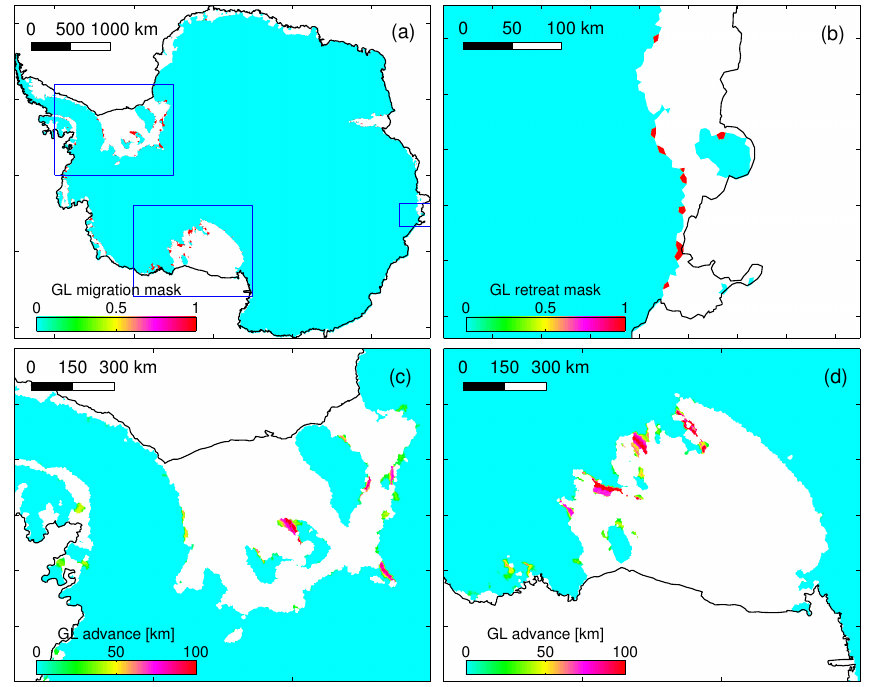
Figure 7. Influence of GIA uplift on the GL. (a) The mask of GL migration associated with the GIA solution at AD 2500. Calculations are based on the hydrostatic equilibrium criterion for the current distribution of ice thickness. Cyan depicts the extent of present-day grounded ice. Red shows the GL migration (mostly advance) due to the GIA uplift. Minor retreats in GL are predicted in a few areas along Wilkes Land in the EAIS; their extents are limited to one or two mesh elements, i.e., ≤ 10km. (b) Mask of example retreat around the Shackleton Ice Shelf, as seen by zooming into the small blue box in Fig. 7a. Other large boxes in Fig. 7a enclose two important regions that are magnified: (c) the Ronne Ice Shelf and the Bellingshausen Sea Sector; and (d) the Ross Ice Shelf. Color codes illustrate the magnitude of GL advance measured along the ice